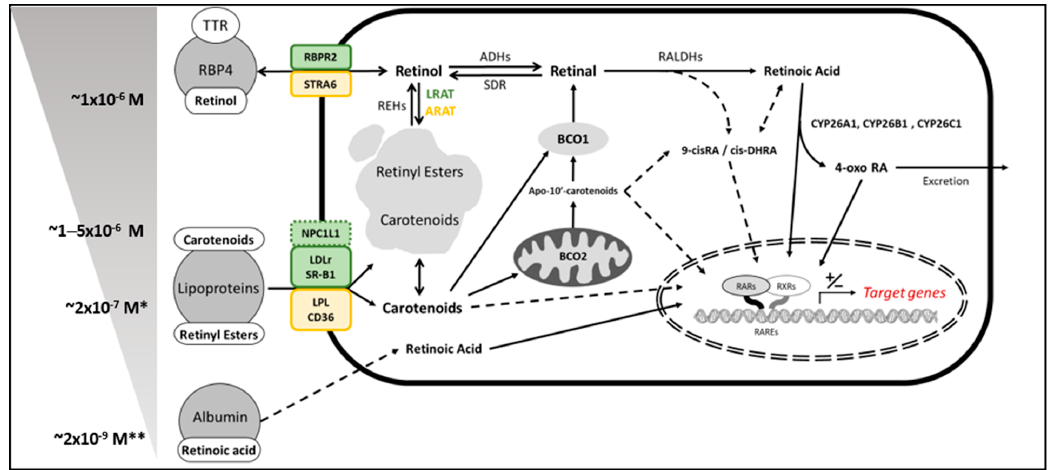
Figure 1. Schematic representation of carotenoid and vitamin A uptake and metabolism. Left : extracellular sources of provitamin A carotenoids (named carotenoids) and vitamin A and the relative concentration. * indicates that these sources can vary more than one order of magnitude depending on the fasting vs. fed conditions. Data show fasting values. Right : main proteins and conversion pathways involved in the uptake, cleavage / conversion and catabolism of carotenoids and vitamin A. For the purpose of this review, we only represented the proteins present in adipocytes and the hepatocytes in yellow and green, respectively. Dotted arrows are pathways not fully established. TTR, transthyretin; RBP4, retinol-binding protein 4; RBPR2, RBP4-receptor 2; STRA6, stimulated retinoic acid gene 6; NPC1L1, Niemann-Pick C1-Like 1; LDLr, Low-density lipoprotein receptor; SR-B1, scavenger receptor class B type 1; LPL, lipoprotein lipase; CD36, cluster of differentiation 36; REHs; Retinyl ester hydrolases; LRAT, lecithin:retinol acyl transferase, ARAT, acyl:retinol acyl transferase; ADHs, aldehyde hydrogenases; SDR, short-chain dehydrogenase/reductase; RALDH, retinaldehyde hydrogenases; 9-cisRA, 9-cis-retinoic acid; cis-DHRA, 9-cis-13,14-dihydroretinoic acid; CYP26s, cytochrome P450s; RARs, retinoic acid receptors; RXRs; retinoid X receptors; RAREs, retinoic acid-response element.